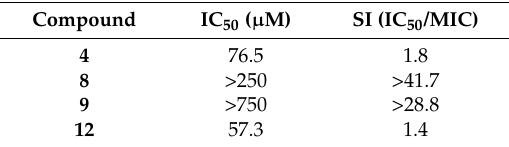
Table 4. Cytotoxicity of active compounds and calculated selectivity index (SI) values.